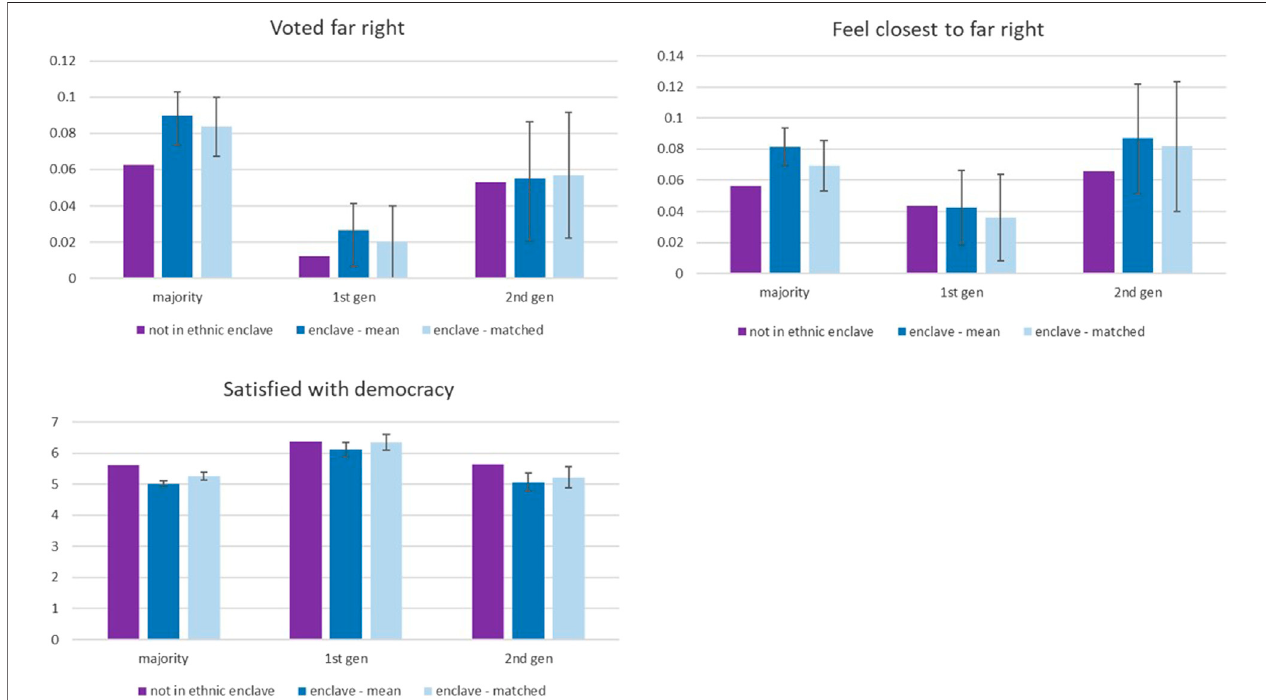
FIGURE 2 | Voting behavior and satisfaction with democracy for inhabitants of an ethnic enclave and those living elsewhere — by migrant status. The mean difference is estimated through an independent samples t -test (two-tailed), and the matched difference shows the estimate after propensity score matching with fi ve nearest neighbors, taking individual sociodemographic factors into account. Outcome variables voting behavior and satisfaction with democracy are examined and the difference between enclave and non-enclave residents reported.